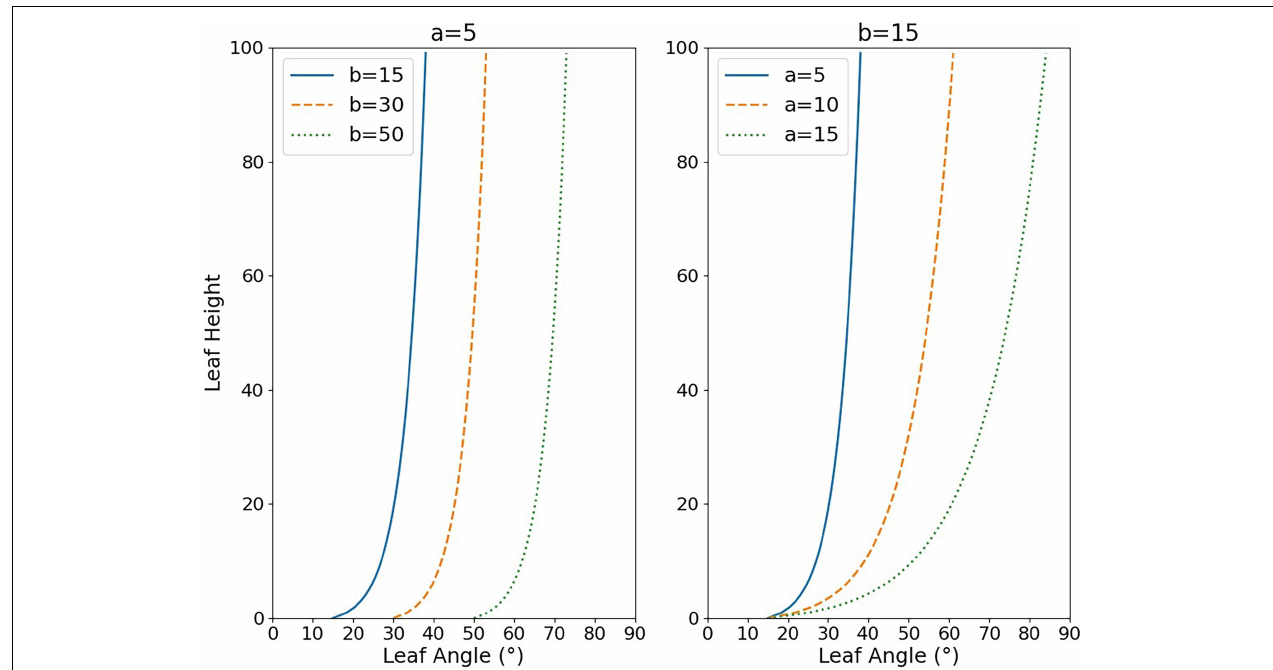
FIGURE 4 | Effect of changes in the values of parameters a and b on the fitted logarithmic function curve shape. The y -axis represents the relative height of the leaf ( RH l ), while the x -axis represents the leaf inclination angle at that height position ( A l